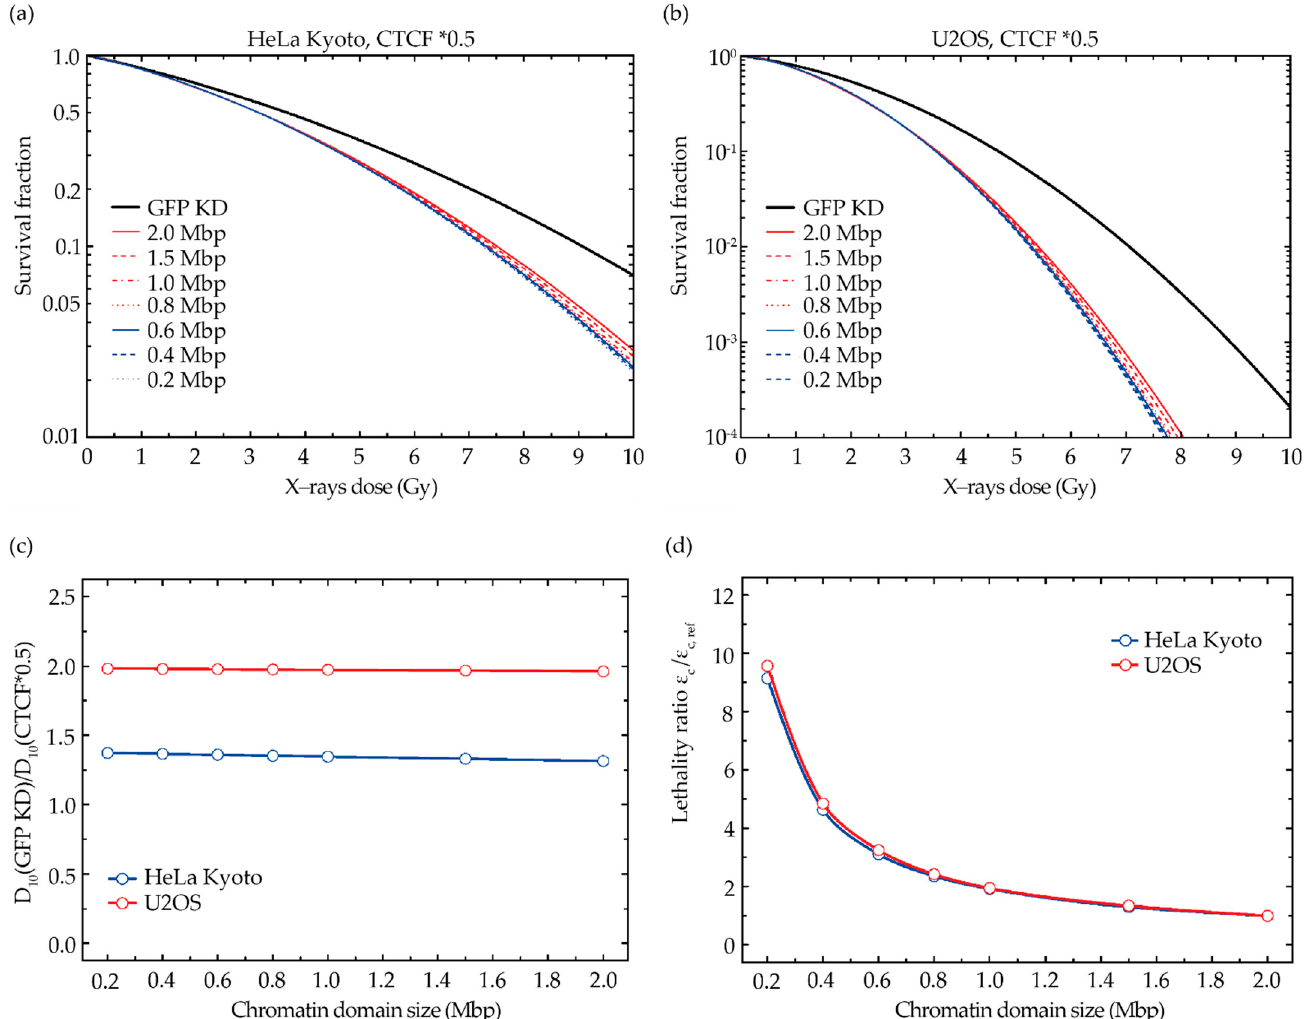
els are shown as dashed lines to indicate the expected impact of the knockdown efficiency. ( a ) GLO- BLE predictions for HeLa Kyoto. ( b ) GLOBLE predictions for U2OS. The same predictions are plot- ted with equal y axis scaling in Figure S5c,d, for comparison.